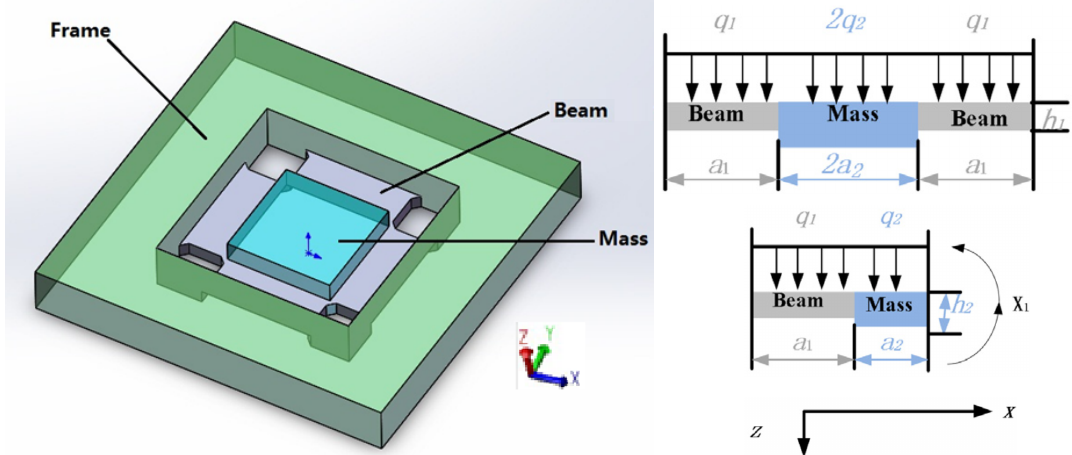
Figure 2. High-G MEMS accelerometer (HGMA) structure schematic and size.